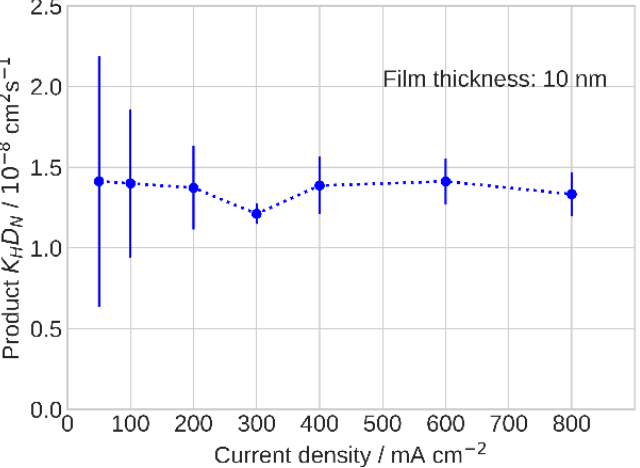
Figure 6. The product K H D N of Henry’s constant for oxygen solubility in ionomer film by oxygen diffusivity in the film vs. cell current density.